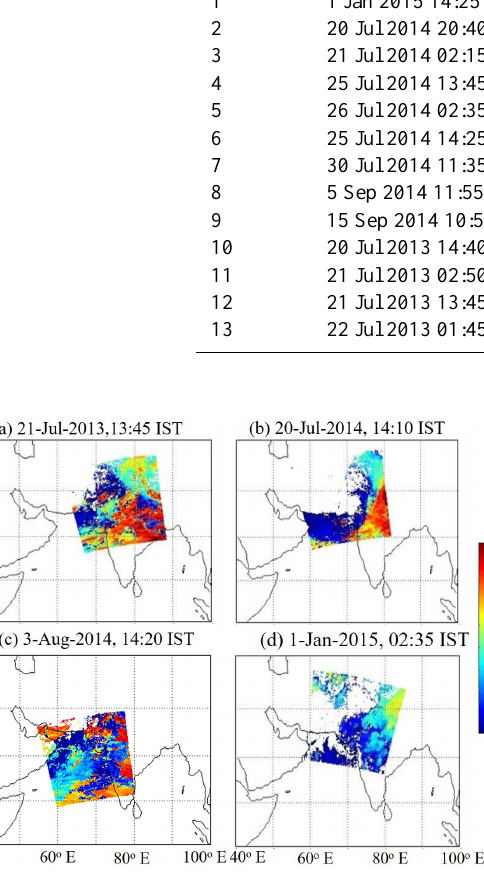
Figure 4. MODIS satellite-retrieved cloud top height for (a) 21 July 2013, (b) 20 July 2014, (c) , 3 August 2014, and (d) 1 January 2015 over Ahmedabad,